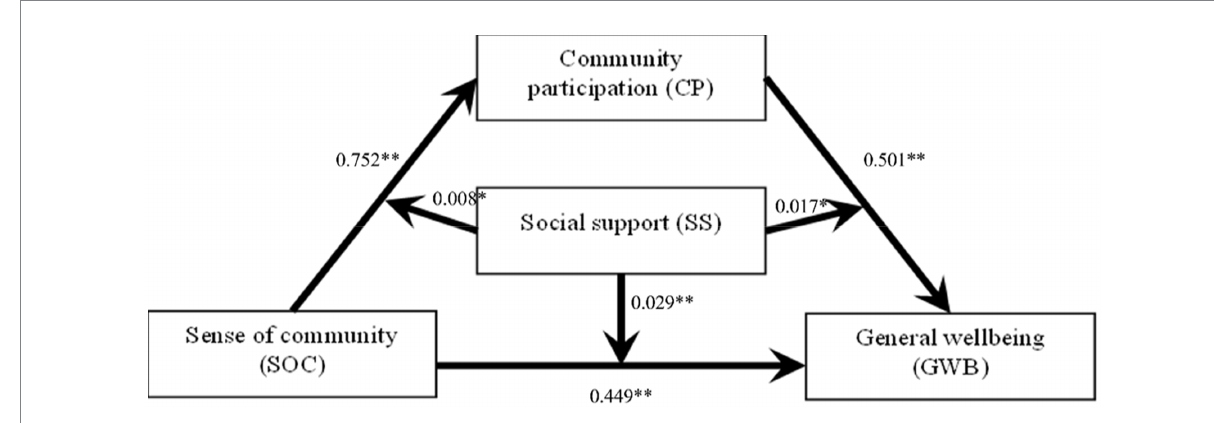
FIGURE 2 The moderated mediation model of social support and community participation. * p <0.05 and ** p <0.01.